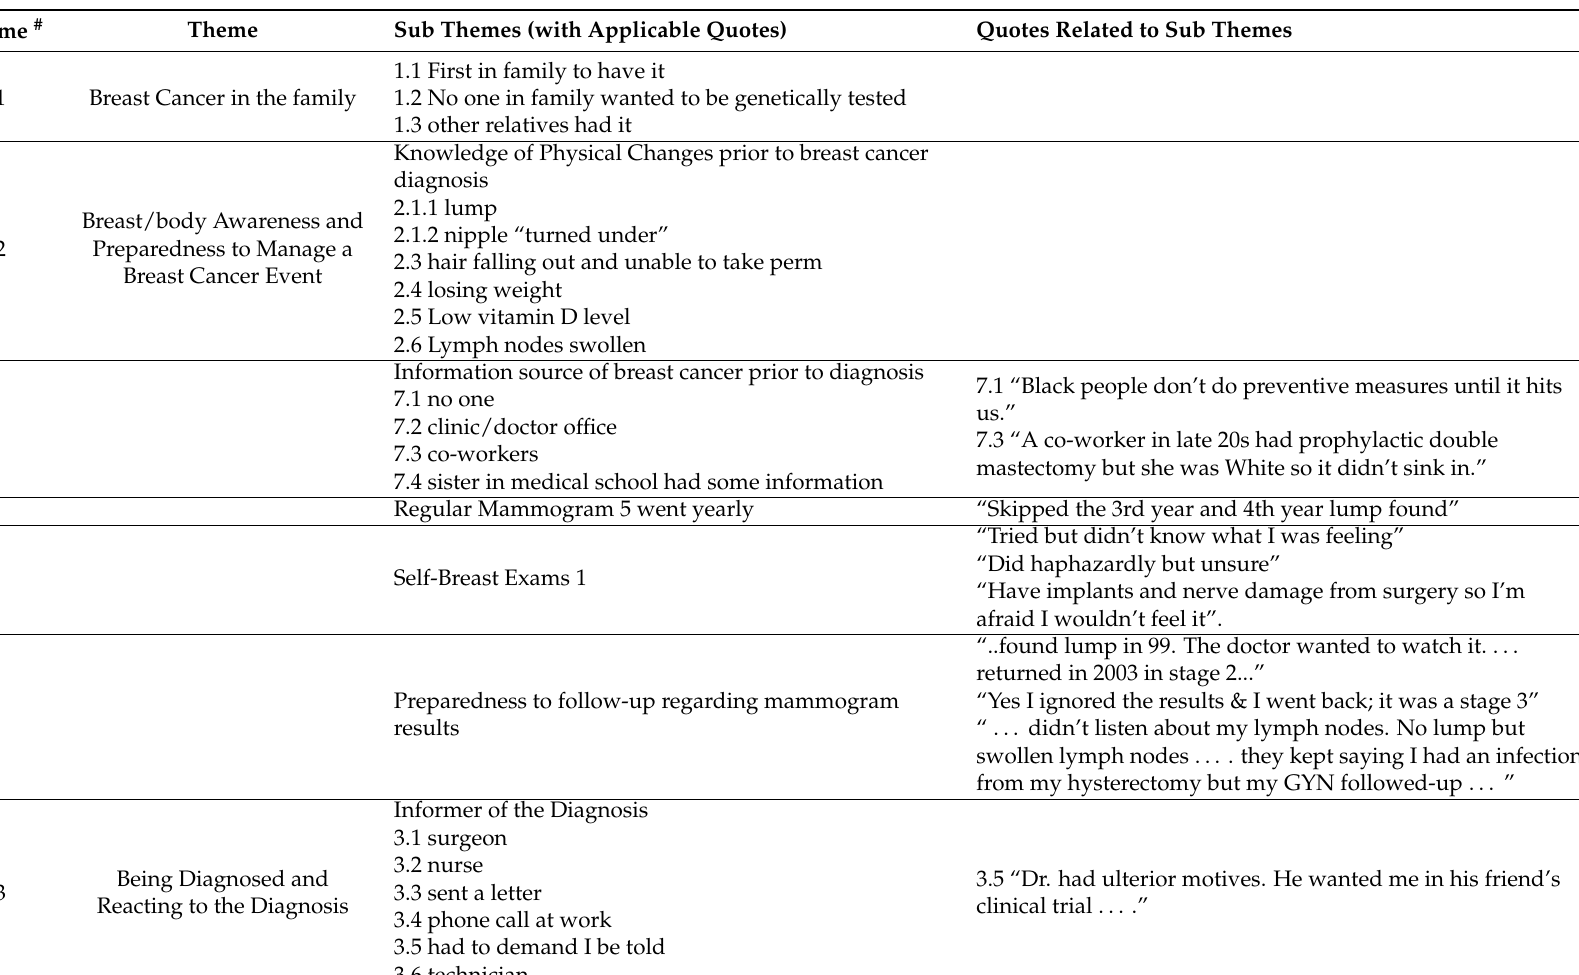
Table 2. Five major themes of African American breast cancer survivors for CHEER focus